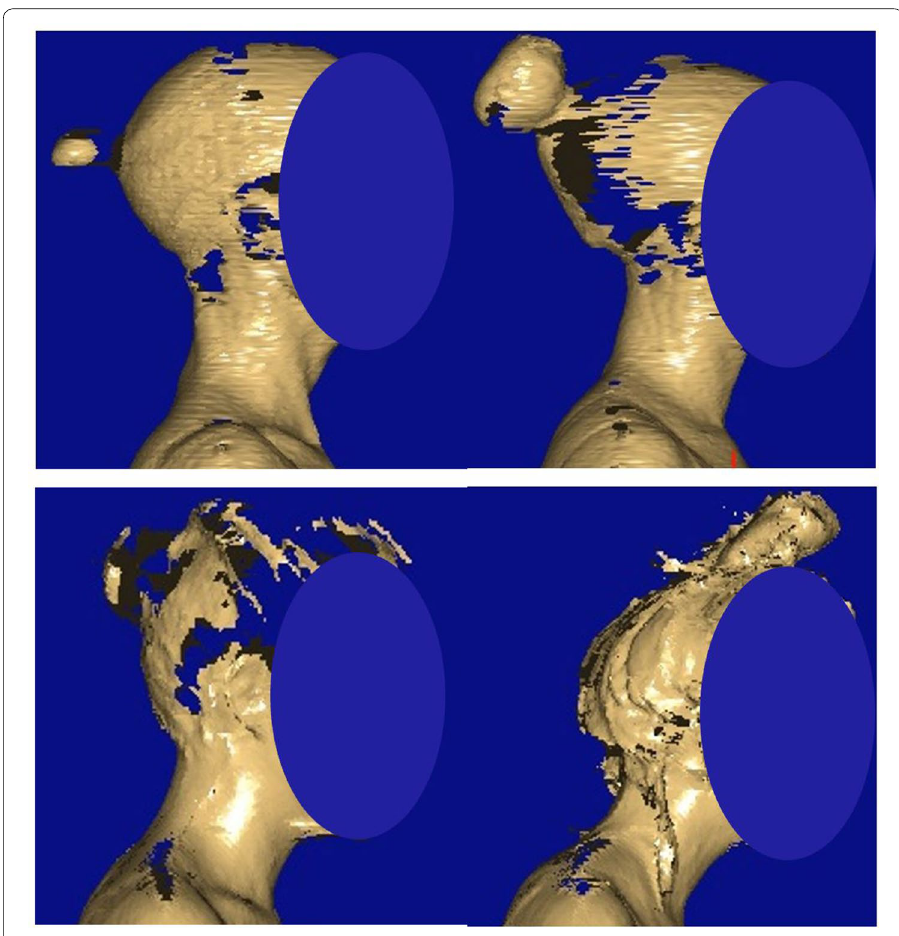
Fig. 7 Examples of neck tilt, from top left, straight, slightly forward, forward, far forward